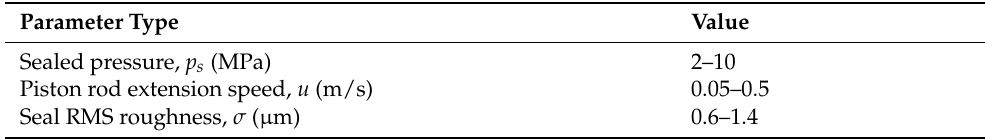
Table 3. Basic operating conditions